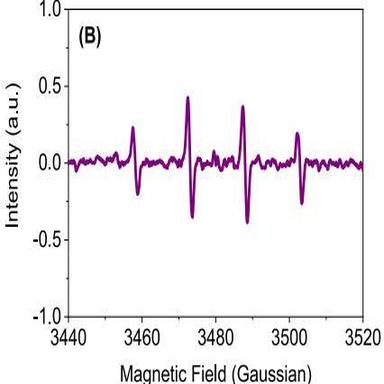
EPR spectra of irradiated (λem ca. 352 nm) aqueous DMPO (10 mM) suspensions in the following media: in the presence of Ti-γAl2O3 (A); in the presence of Ti-γAl2O3 and CHL (0.1 M) (B); in the presence of Ti-γAl2O3 and TBA (0.1 M) (C); in the presence of TiγAl2O3 and FFA (0.1 M) (D). EPR spectra of irradiated (50 W HBO lamp using a 320 nm cut-off filter) suspensions of DMPO (10 mM) in DMSO in the following media: in the presence of γAl2O3 (E); in the presence of Ti-γAl2O3 (F). 1 mg/mL of the photocatalyst was